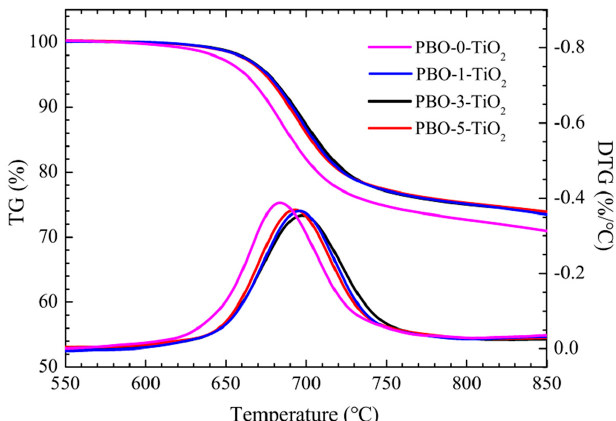
Figure 7. Thermogravimetric (TG) and DTG of PBO fibers under N 2 with a heating rate of 10 °C per minutes.